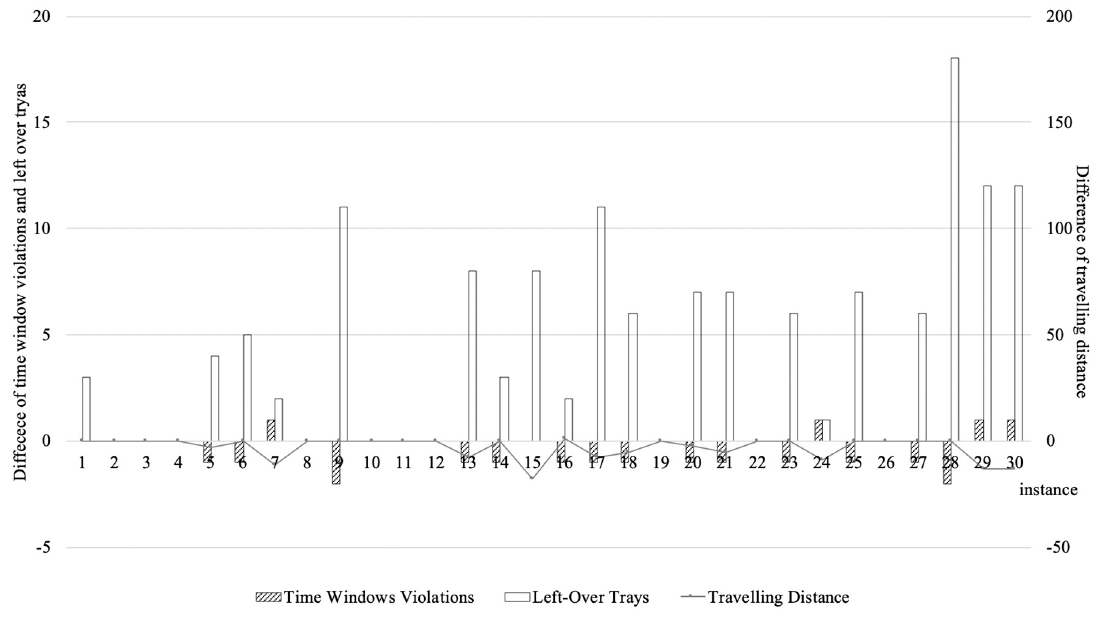
Figure 1. Performance comparison of time window violations and left-over trays.